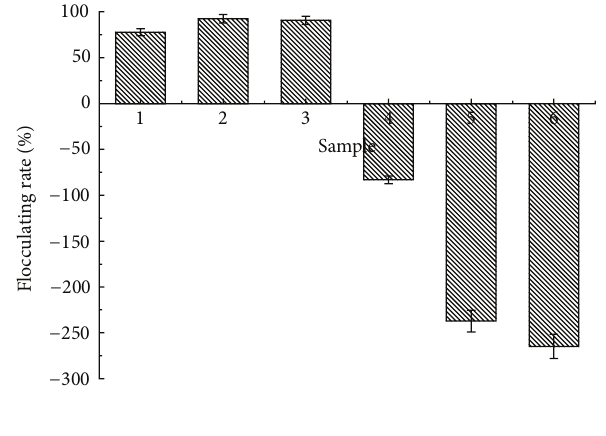
Figure 1: Distribution of flocculent active ingredients.